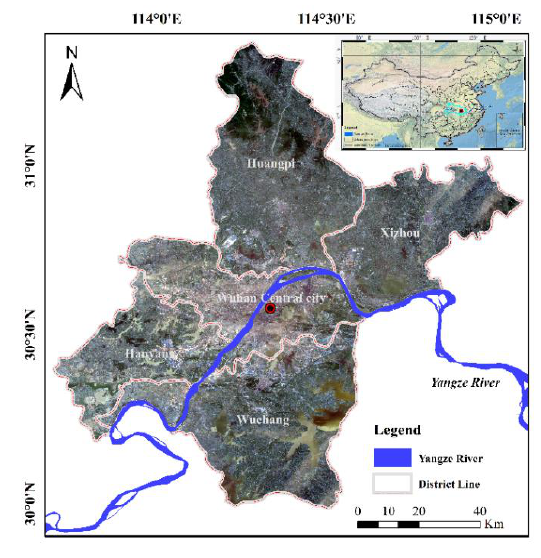
Figure 1. The process flow of the proposed method.